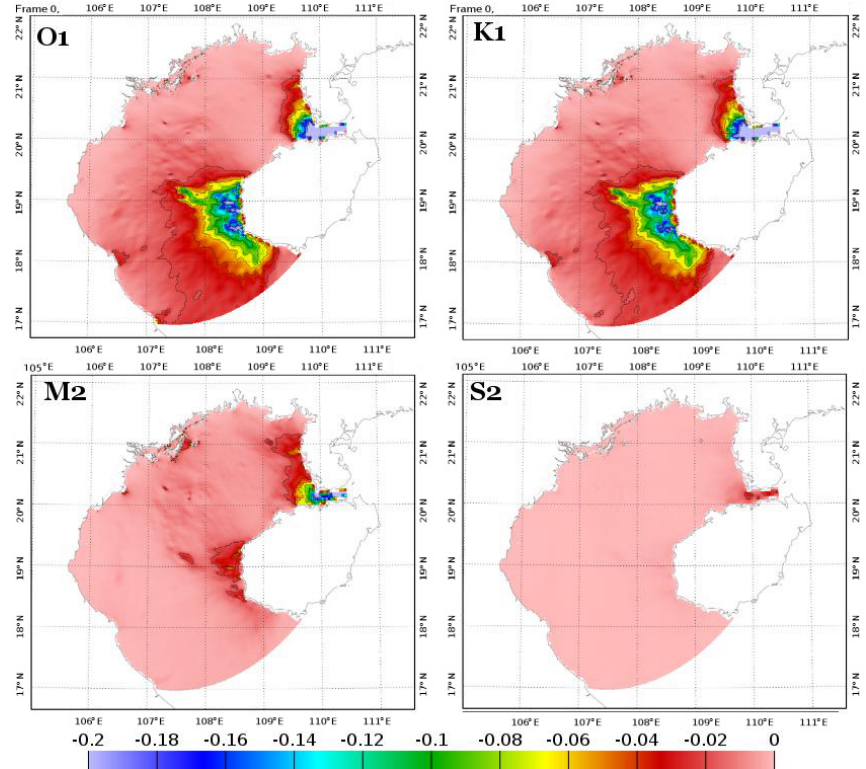
Figure 14. Bottom dissipation flux (in watts per square meter) for O 1 , K 1 , M 2 , and S 2 computed from model outputs of simulation Test